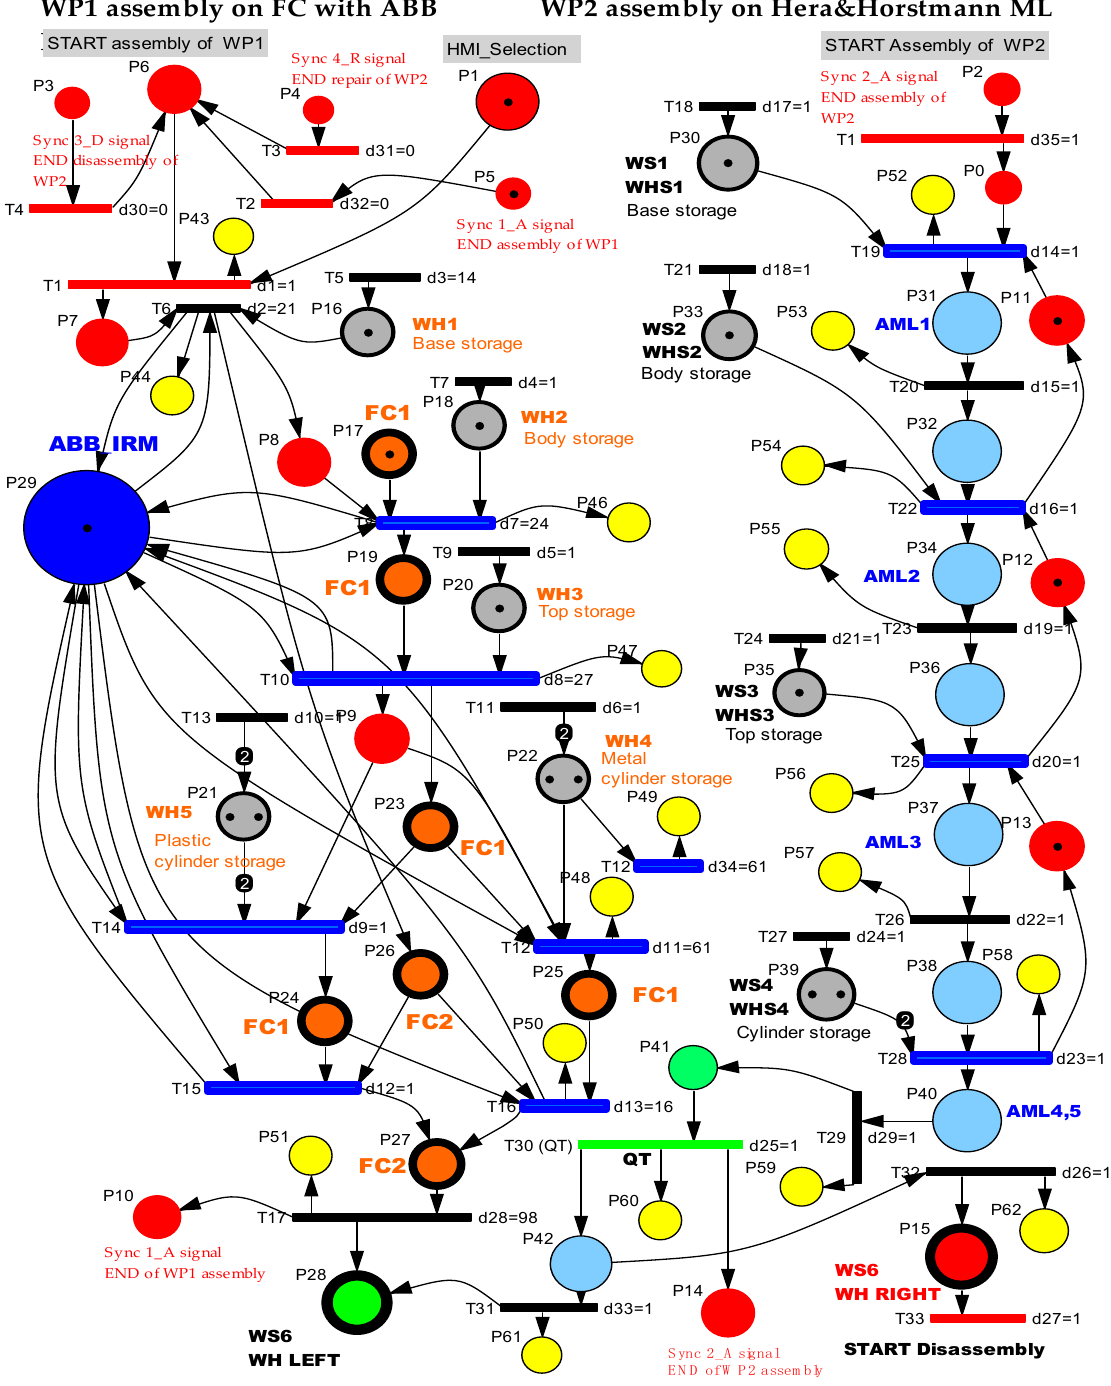
Figure 8. SPN, synchronized Petri net, for WP1 assembly on FC with ABB IRM and WP2 assembly on A/DML Hera & Horstmann.